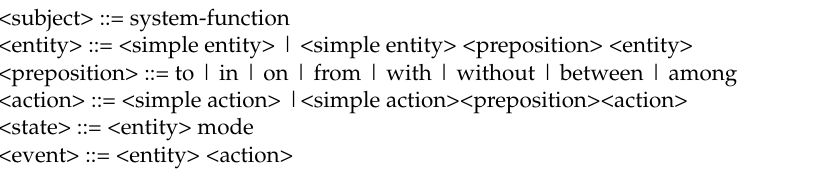
Table 6. Boilerplate Grammar